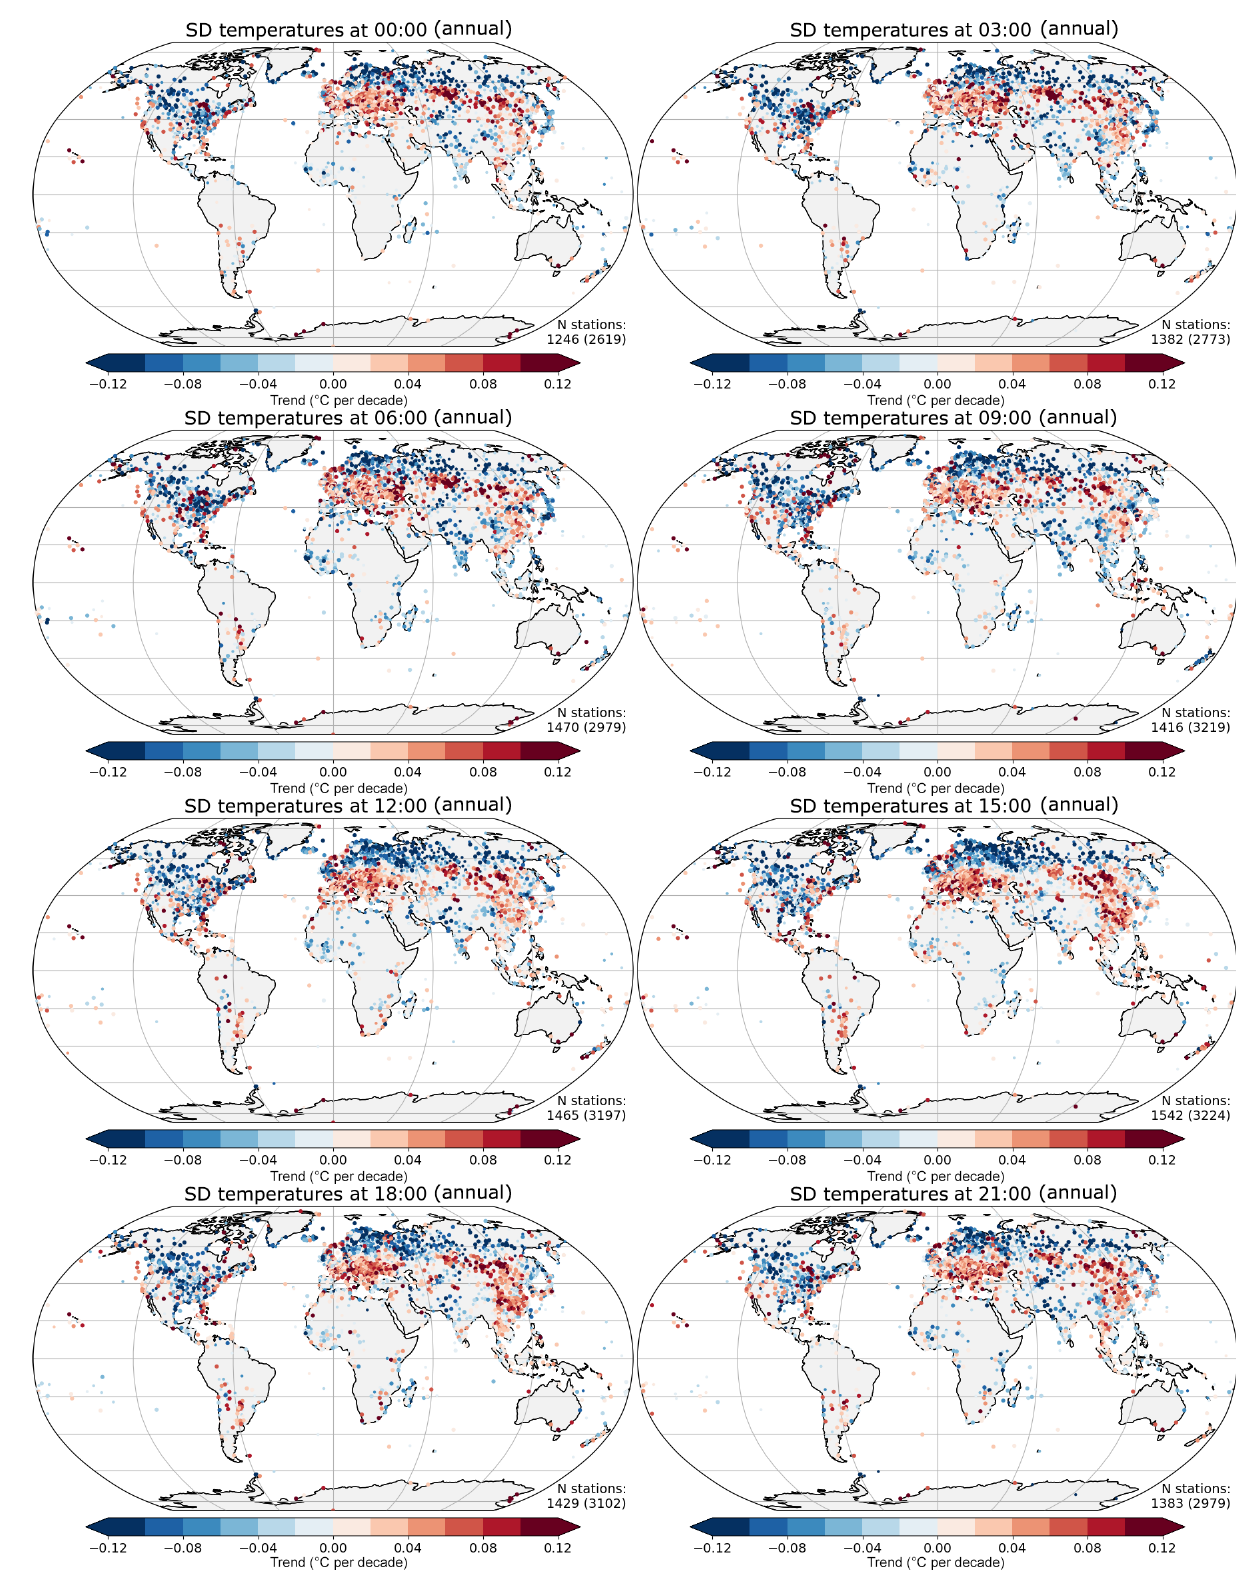
Figure 6. Trend over 1974–2018 in distribution standard deviation for temperature at each 3-hourly interval. The stations where the 1 ˆ σ range of the fitted trend excludes zero are plotted with a larger symbol (the number of these is shown in the bottom right-hand corner of each plot). The total number of stations available is shown in